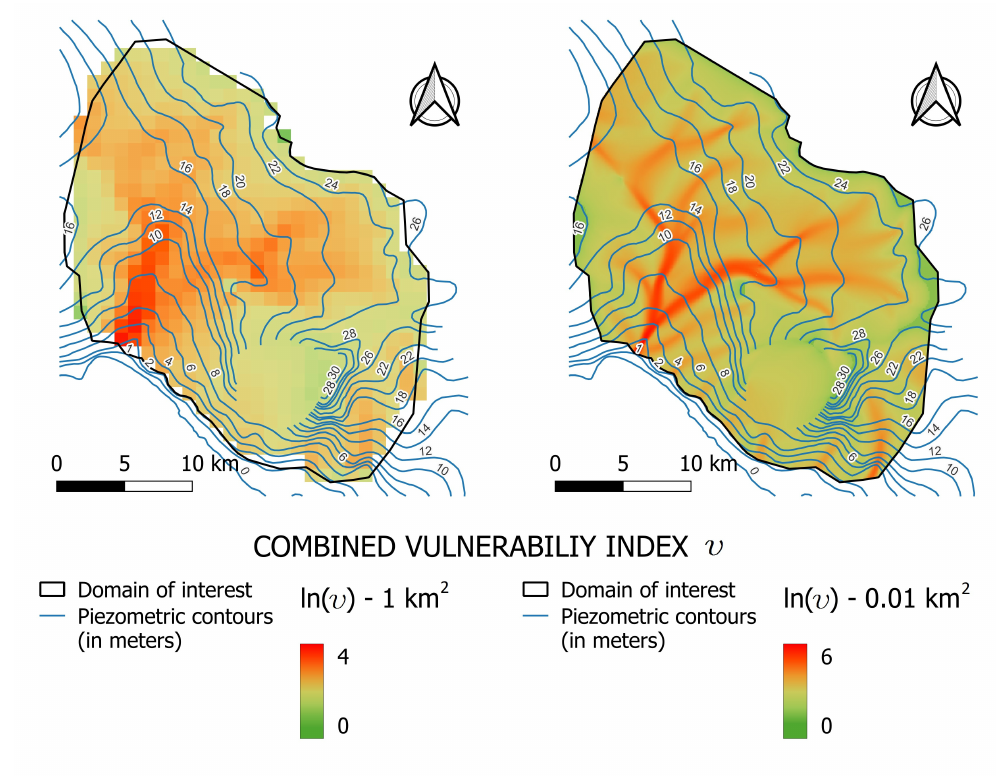
Figure 4. Combined vulnerability index υ depicted in a log-scale for 2 different discretizations (1 km 2 –0.1 km 2 ). The piezometric contours and the area analyzed are also shown. The index is highly variable as it depends on the highly variable groundwater subcatchments drained by each